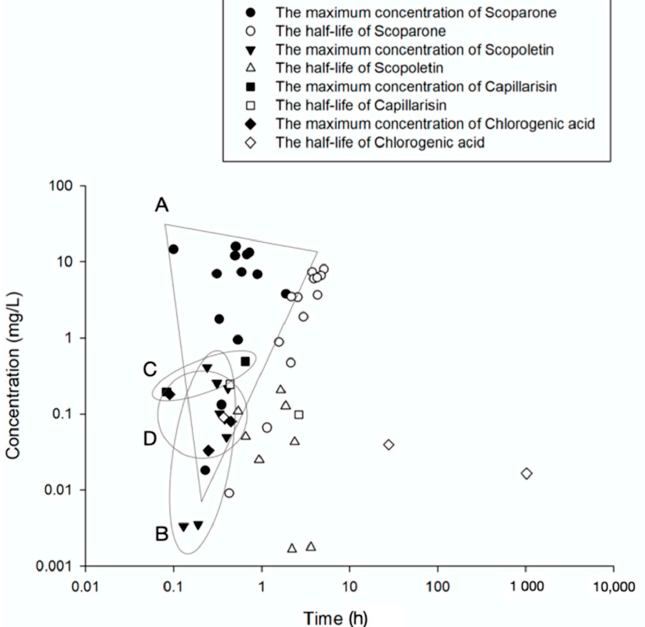
Figure 3. The pharmacokinetic extent of bioactive compounds in Artemisia capillaris . The figure illustrates the absorption and elimination of scoparone, scopoletin, capillarisin, and chlorogenic acid in vivo after oral administration of Artemisia capillaris extracts. The black symbols represent the maximum concentration (C max ) of the main bioactive compounds, including scoparone, scopoletin, capillarisin, and chlorogenic acid. The white symbols represent the half-life (t 1/2 ) of these compounds. A, B, C, D indicate the area of the C max of scoparone, scopoletin, capillarisin, and chlorogenic acid,